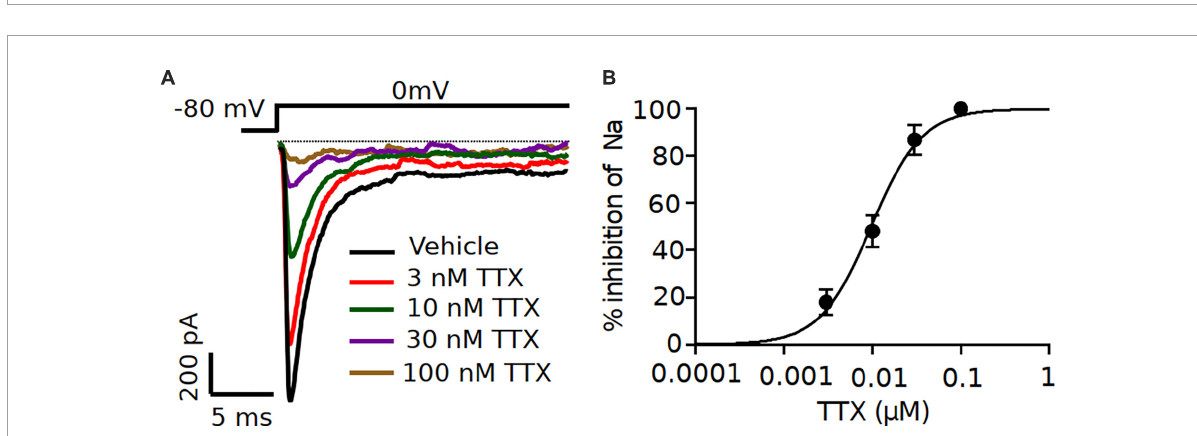
FIGURE2 Increasing concentrations of TTX resulted in a concentration-dependent inhibition of Na + currents in mouse cortical pyramidal neurons. (A) Representative traces of Na + currents from pyramidal neurons recorded in vehicle condition and in presence of TTX at concentrations of 3, 10 30 and 100 nM. Inhibition by TTX of Na + currents were elicited by a 20-ms pulse depolarized from a holding potential of –80 mV to 0 mV. (B) Concentration-response relationship for TTX inhibition of Na + current in pyramidal neurons. Each point shows Na + peak current relative to vehicle averaged over 7 neurons, except for 100 nM TTX ( n = 3). The solid line is the best fit of the average data to the Hill equation yielding IC 50 = 9.2 nM.